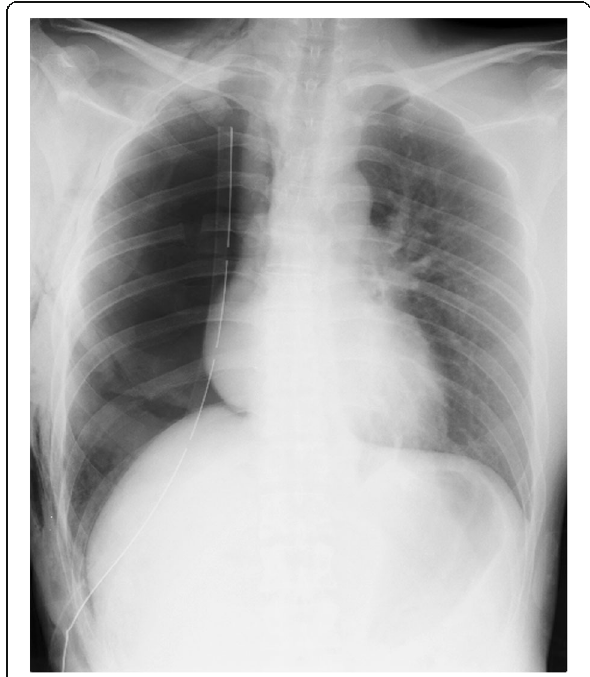
Fig. 2 Chest radiograph after the elevation of the chest drain ’ s suction pressure from 7 to 15 cmH 2 O. This reveals improvement of the mediastinal shift and adequate dilation of the left